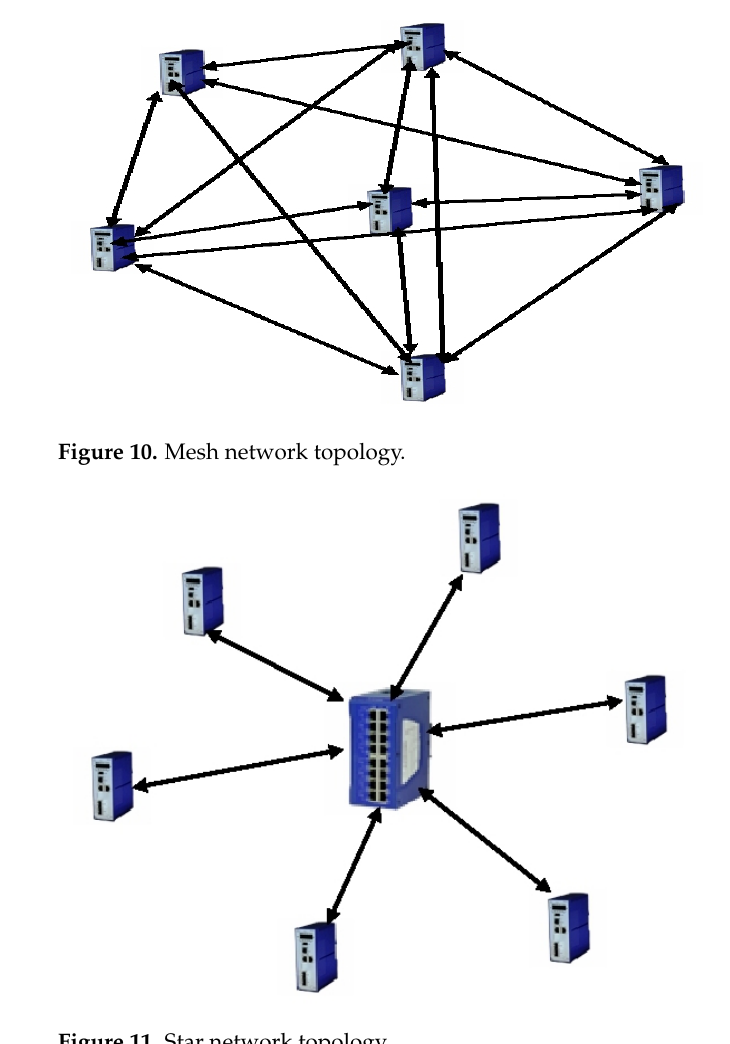
Figure 11. Star network